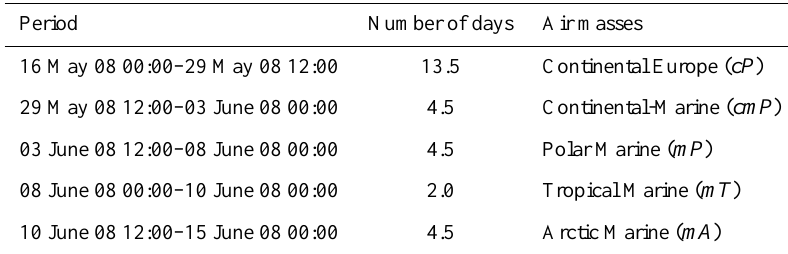
Fig. 1. Typical air mass back trajectories for (a) cP , (b) cmP (c) mP , (d) mT , (e) mA air masses and (f) MODIS chlorophyll- a maps. Table 1. Summary of the five different